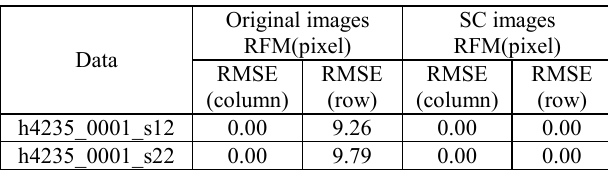
Table 3. Fitting residuals of original and SC images RFM